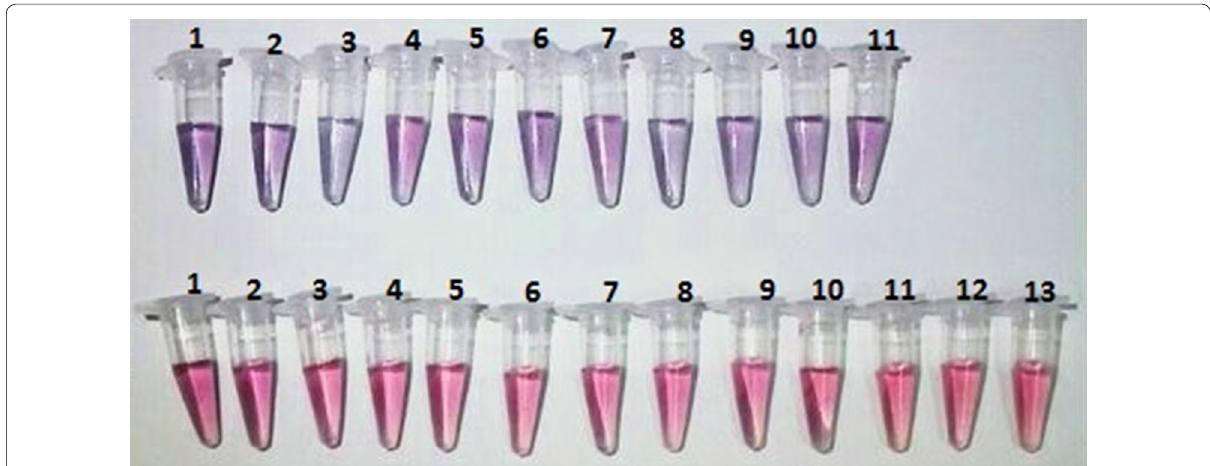
Fig. 3 Visual observation of PNA-AuNP colorimetric assay in presence of negative and positive samples. Upper row is negative samples from left to right , 1 mismatched DNA target, 2 deleted DNA target, 3 FMDV, 4 BoHV, 5 P. multocida , 6 E. coli O157:H7, 7 M. bovis , 8 BLV, and 9 – 11 negative field samples. Lower row is positive samples from left to right , 1 BVDV-NADL; 2 BVDV-2, 3 – 8 positive field samples, and 9 – 13 archived isolates